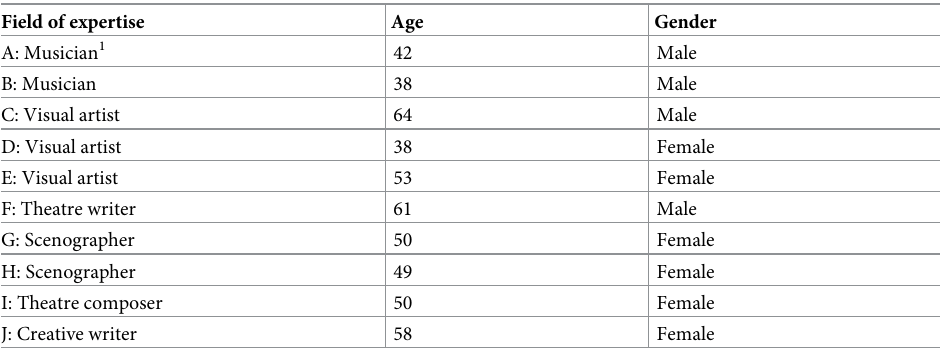
Table 1. Participating